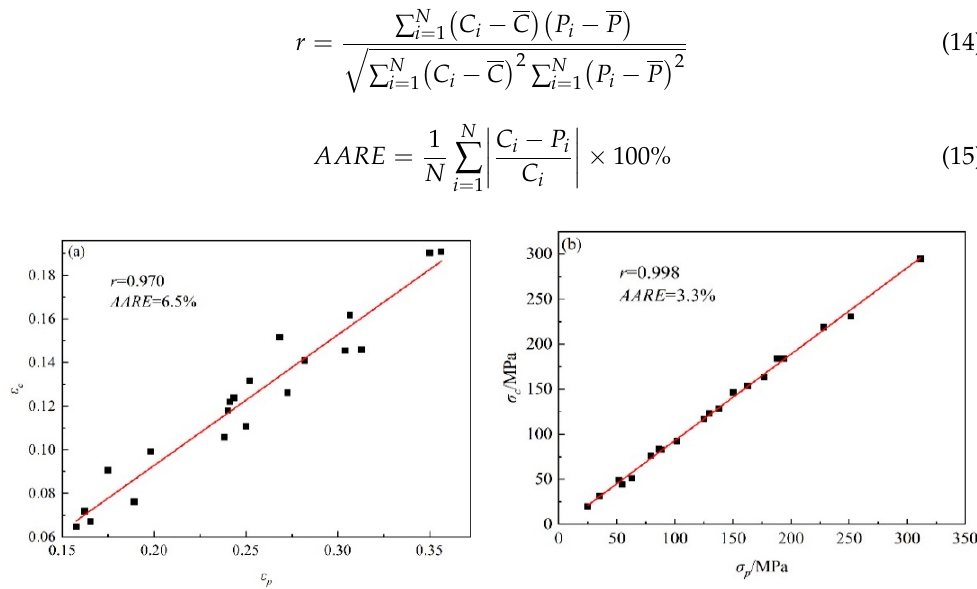
Figure 14. Relationship between ε c − ε p and σ c − σ p of S280 steel: ( a ) ε c − ε p ; ( b ) σ c − σ p .